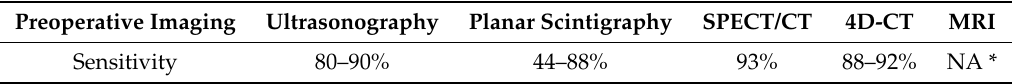
Table 1. Sensitivities of preoperative